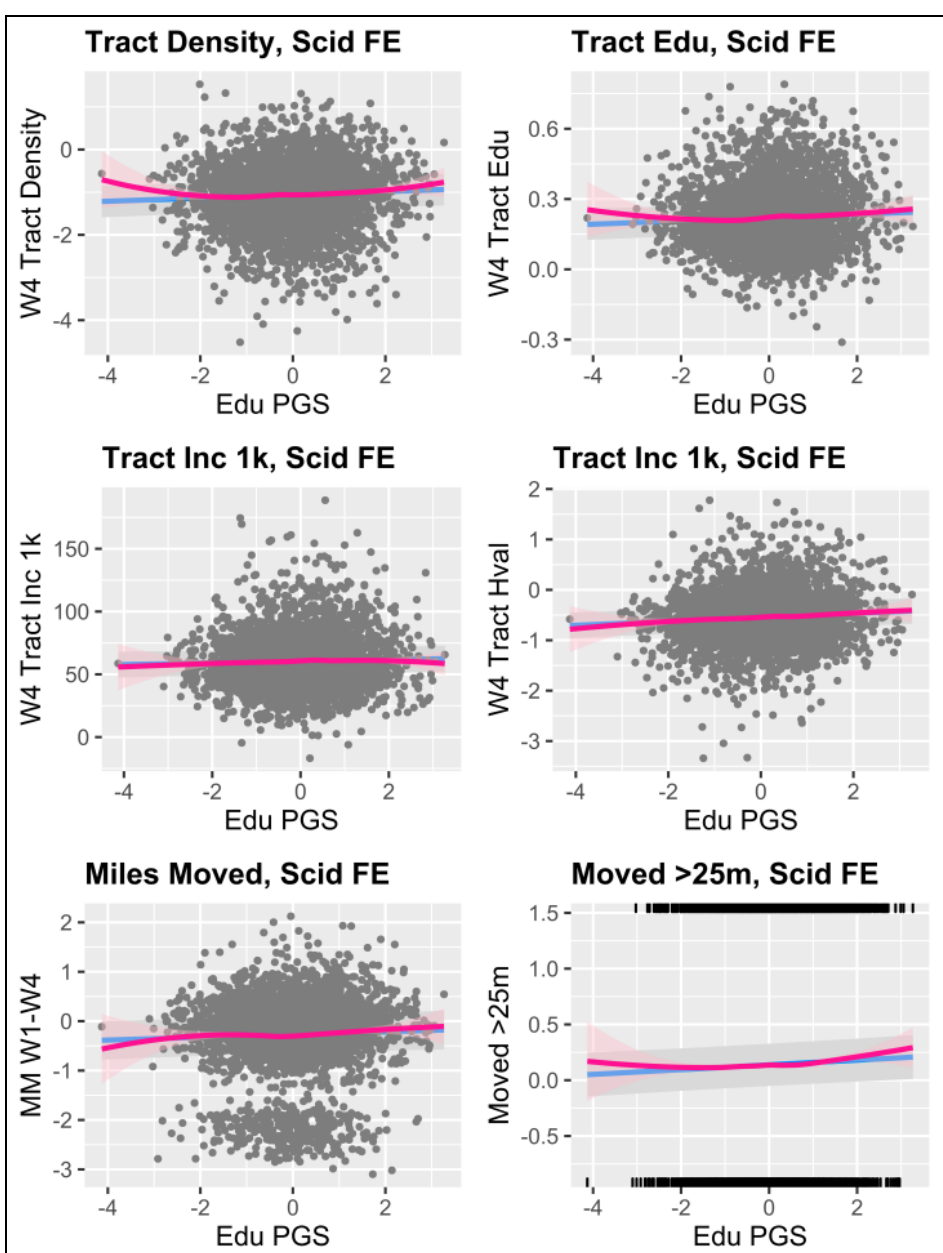
Figure 3: Visualized regression lines for individual educational PGS predicting neighborhood conditions in wave 4 and distance traveled between waves 1 and 4 in school fixed-effects models. Regression lines (blue for linear, pink using Loess smoothing) are consistent with the estimates contained in Table 1 and produced using the visreg package in R (see Breheny and Burchett [2017]). Edu, educated; FE, fixed effects; Inc, income; MM, miles moved; Scid, school